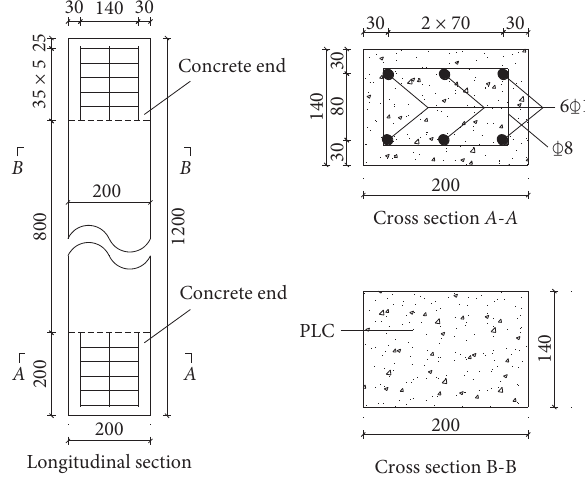
Figure 1: Unreinforced specimens details.